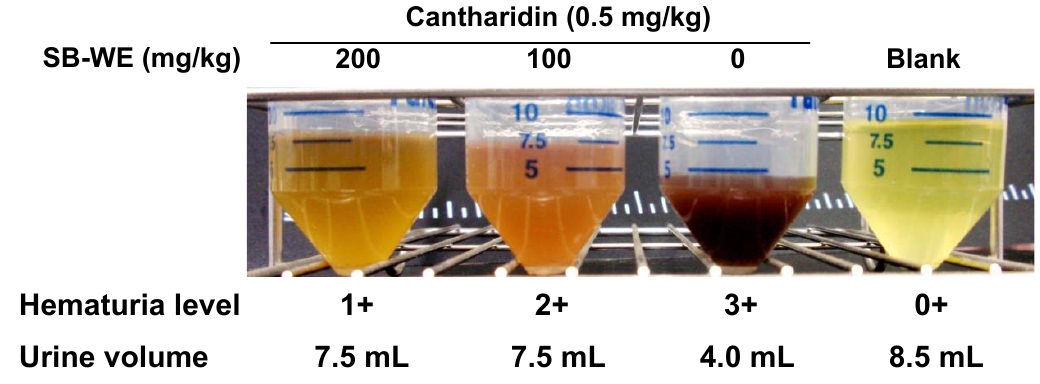
Figure 3. The boiling-water extract of S. baicalensis (SB-WE) dose-dependently alleviated cantharidin-induced hematuria and dysuria in Wistar